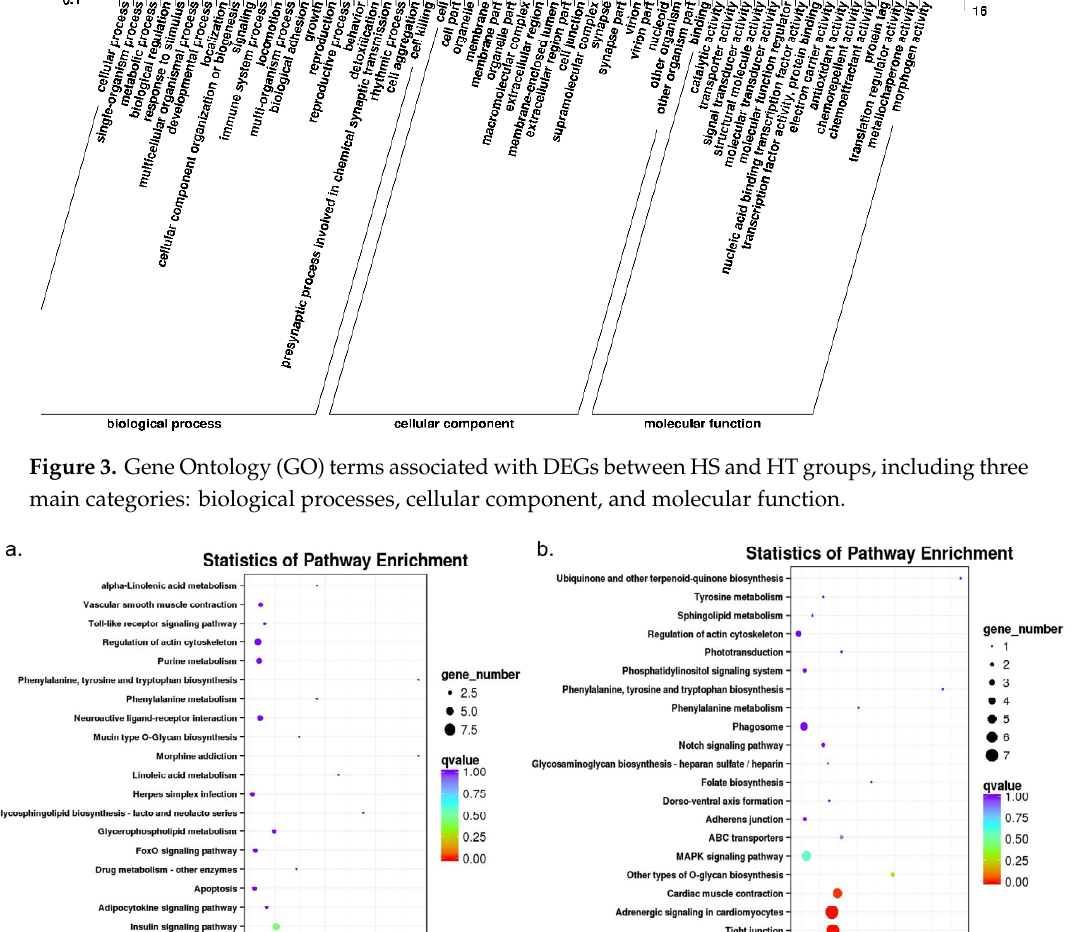
Figure 4. Kyoto Encyclopedia of Genes and Genomes ( KEGG) pathway enrichment of the DEGs in up-regulation ( a ) and down-regulation ( b ) of genetic responses to hypoxia stress in bighead carp. The size of colored dots represents the number of significant DEGs associated with each corresponding pathway.